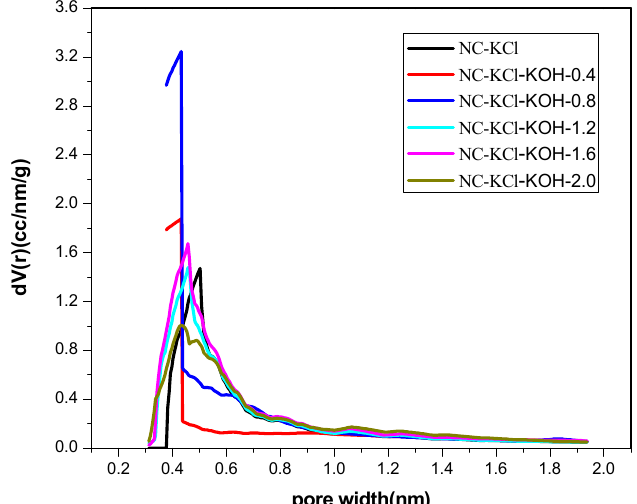
Figure 9. The micropore size distribution of samples activated by different amount of KOH and 0.75 g KCl per 2.20 g resorcinol.